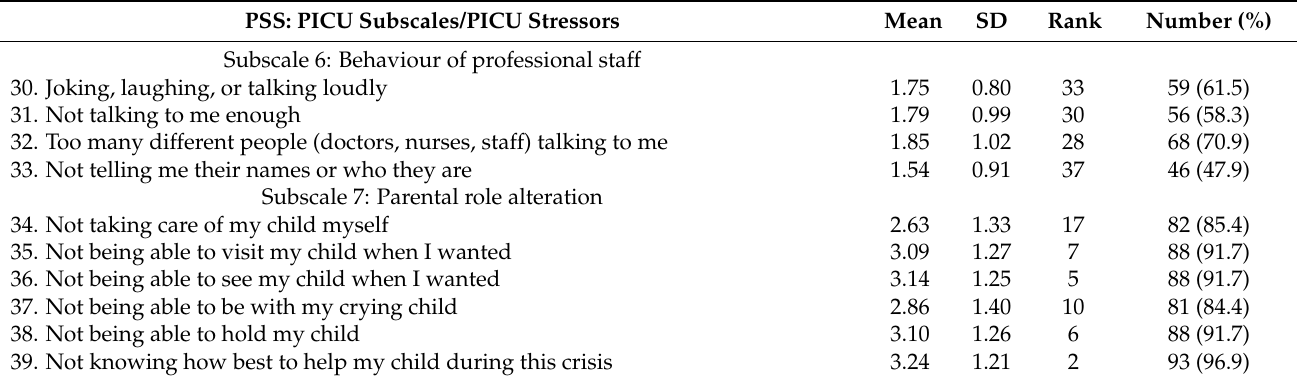
PSS: PICU Subscales/PICU